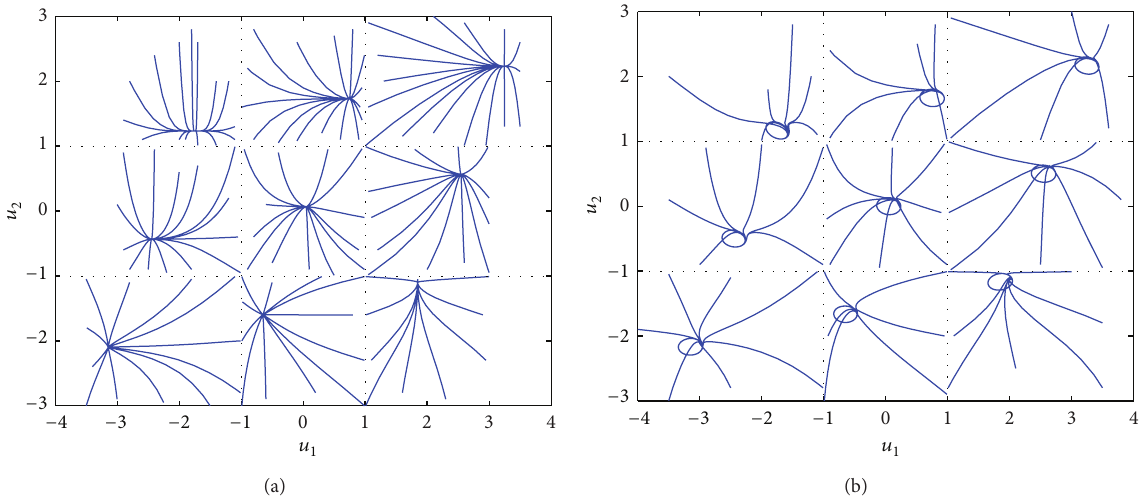
Figure 1: Transient behaviors of the state variables 𝑢 1 (𝑡) and 𝑢 2 (𝑡) with different initial values in Example